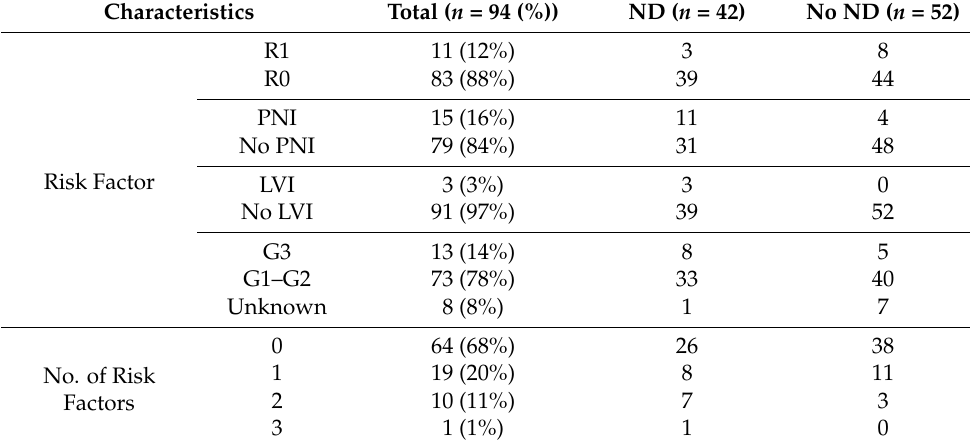
Table 3. Description of risk factors according to depth of infiltration (DOI), postoperative radiother- apy (PORT), and neck dissection.